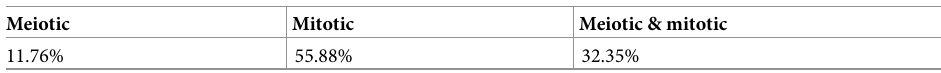
Table 1. Aneuploid types of